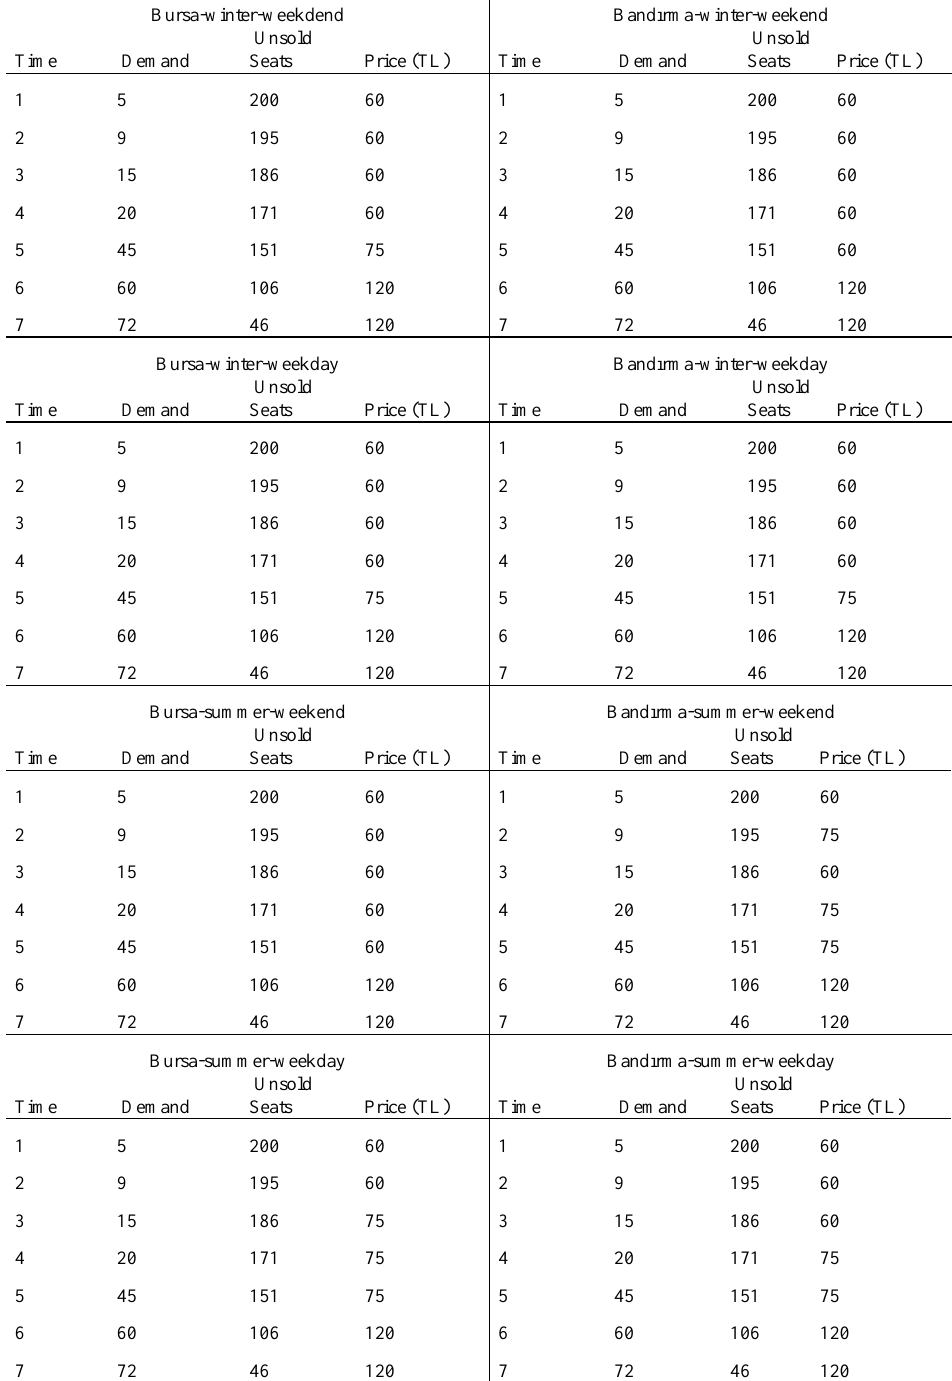
Table 5. Optimal dynamic pricing